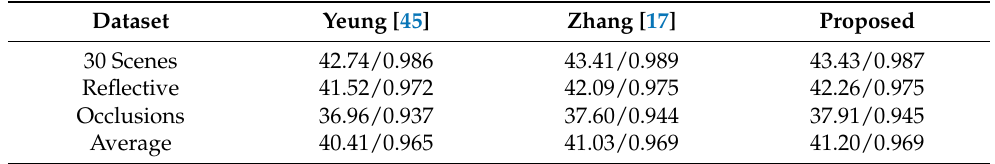
Table 3. Numerical comparison (PSNR/SSIM) of the proposed model for LF reconstruction using the